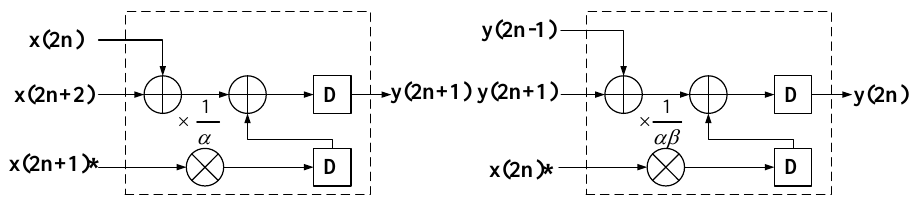
Figure 1. Basic operation structures of (1) and (2). Note: The items with * are the multiplication terms that should arrive ahead of